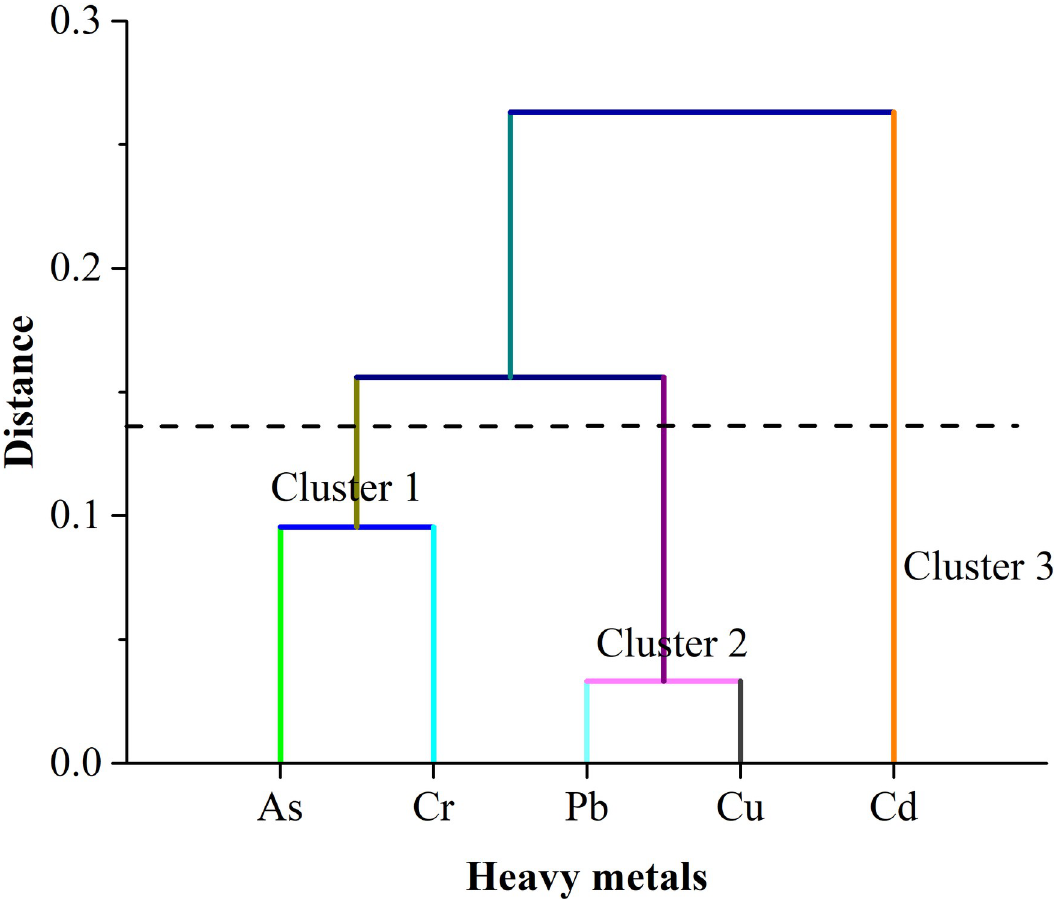
Fig 3. Hierarchical cluster (dendrogram) using Ward linkage method among the experimented metals in fish species.